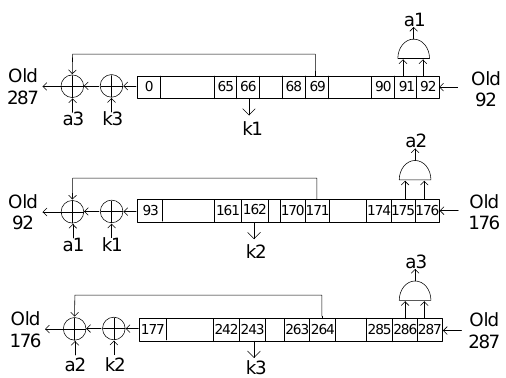
Figure 8. Schematic representation of the backward Trivium